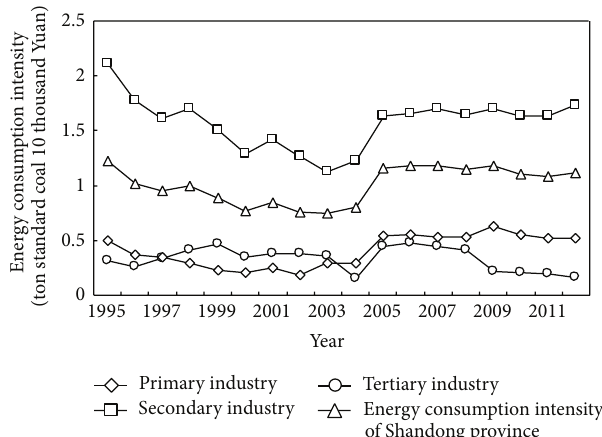
Figure4:EnergyconsumptionintensityofShandongprovincefrom 1995 to 2012.